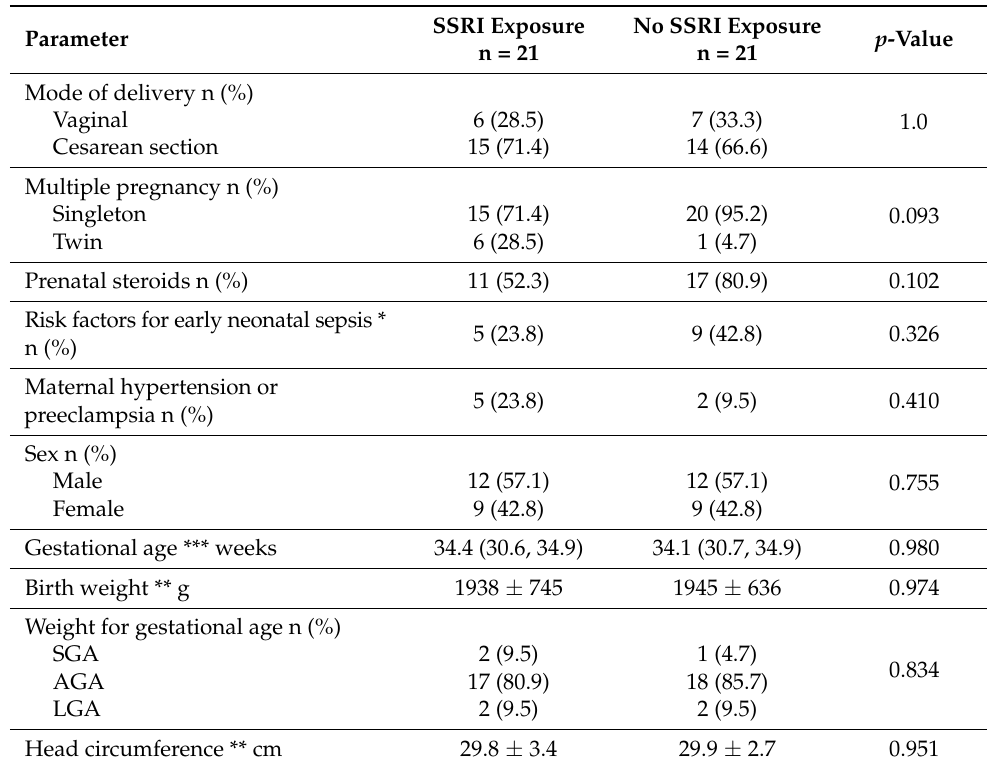
Table 1. Baseline maternal and neonatal characteristics.